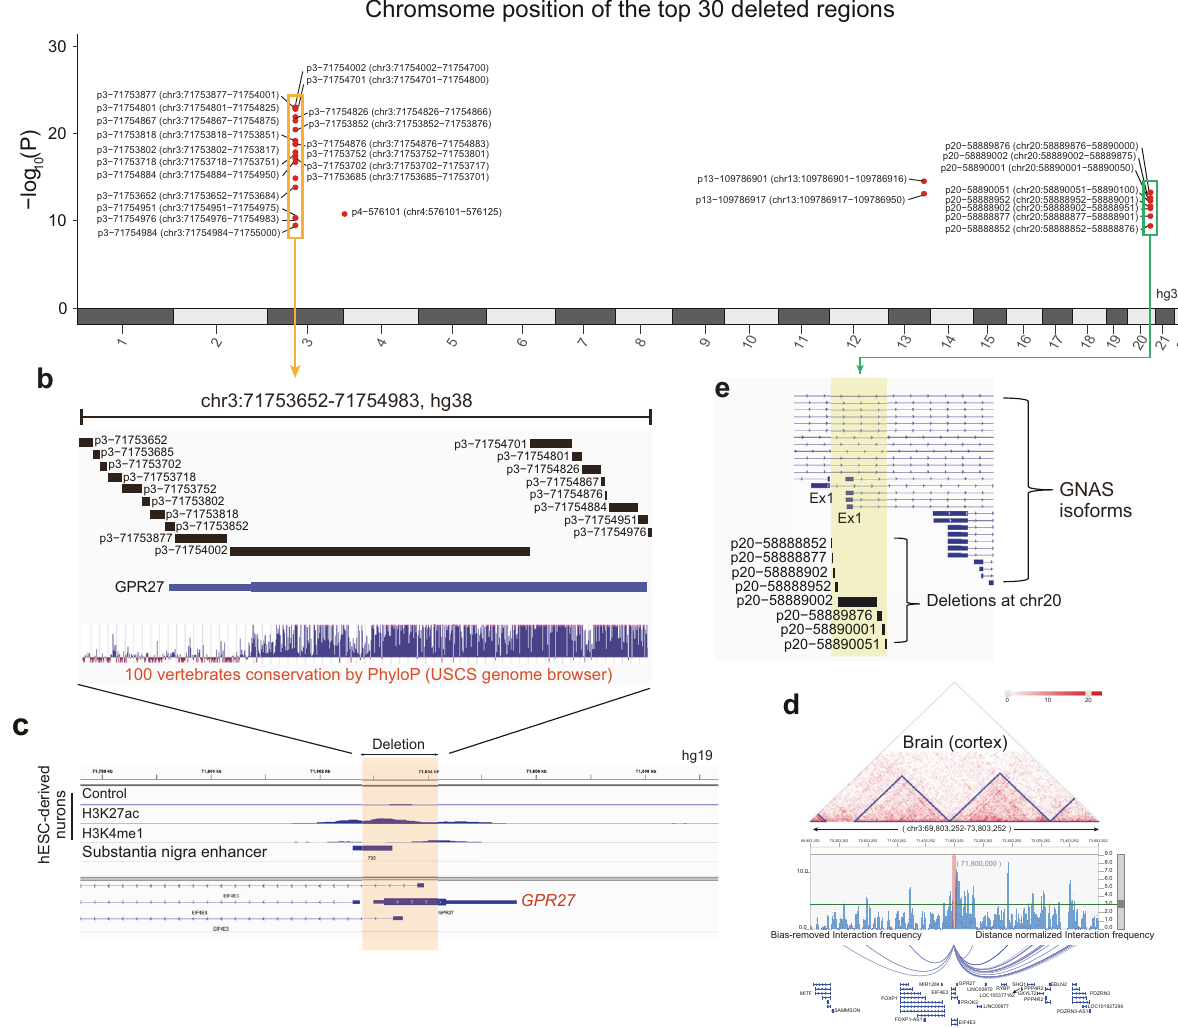
Fig. 5 SGDs associated with risk of PD. a SGD loci clustered at chr3:71753652 – 71754983 are mainly located at GPR27 and b show high conservation in multiple vertebrates. c High enhancer signals at the SGD loci in GPR27 . d SGD loci are located in the TAD with multiple interactions. e SGD loci at chr20 are mainly located in the promoter region of the GNAS isoform. HC healthy control; PD Parkinson ’ s disease; SGD small genomic deletions; TAD topologically associated between CNVs and gene expression in the central nervous system (CNS) (Fig. 6e). According to GTEx data, GPR27 expression correlated signi fi cantly with SNCA expression in various normal brain tissues, including the substantia nigra (Fig. 6f), and this correlation was also demonstrated using CCLE data (Fig. 6g). Consequently, higher SNCA expression was noted in the cell line group with GPR27 CN loss (Fig. 6h), suggesting that SNCA mediates the signaling pathway through which GPR27 CN loss contributes to PD pathogenesis. To obtain additional evidence supporting the pathological role of GPR27 CN loss, we conducted pathway analyses using data obtained from the CCLE database. GSEA using CCLE data from CNS samples revealed a downregulated dopamine neurotransmitter release cycle in the GPR27 CN loss group compared to that in the GPR27 CN neutral group (Fig. 6i). Collectively, these fi ndings suggest that germline GPR27 CN loss contributes to PD development.